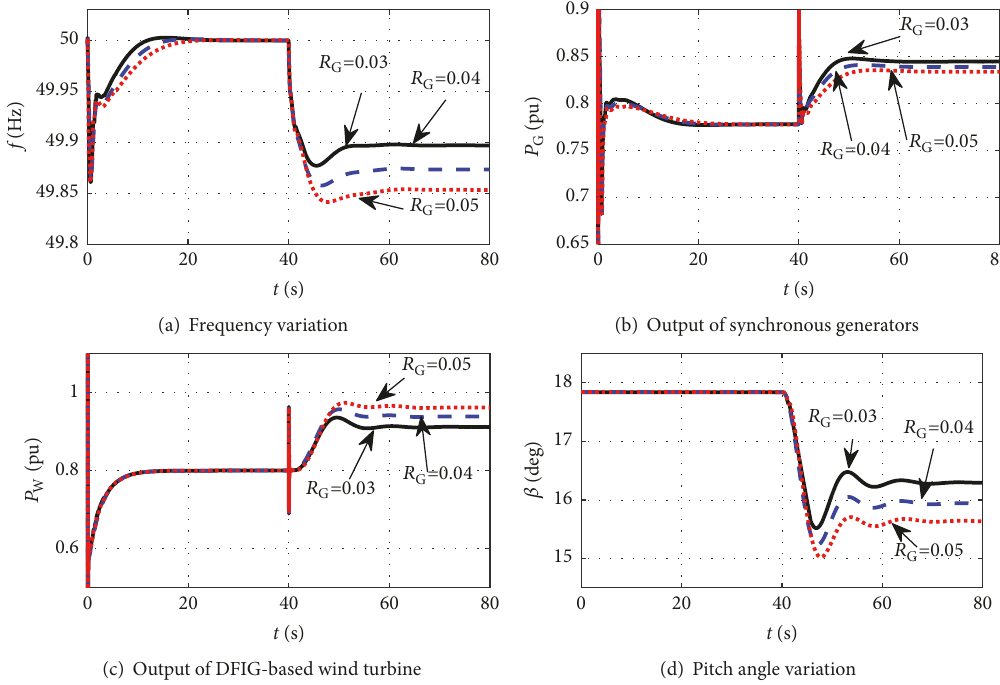
Figure 9: Simulation diagram of the power constant area when frequency variation is less than